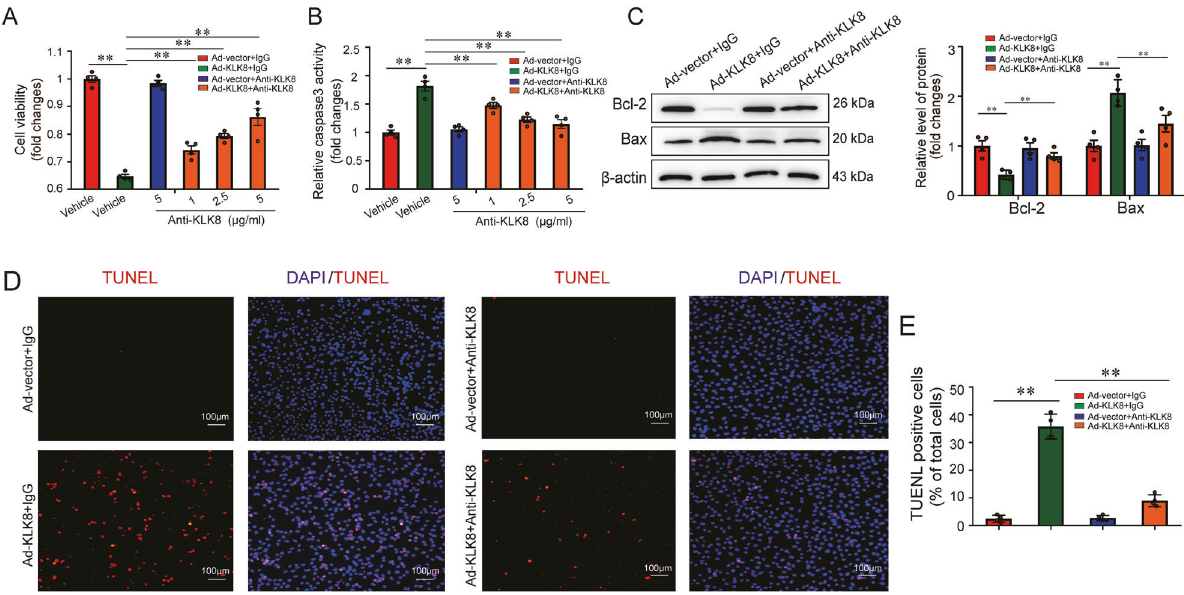
Fig. 5 Anti-KLK8 neutralizing antibody rescues KLK8-overexpressed neuron cells from apoptosis. HT22 murine hippocampal neuronal cells were infected with KLK8 adenovirus (Ad-KLK8) at a multiplicity of infection (MOI) of 3 for 24 h with or without anti-KLK8 neutralizing antibody at the indicated doses. A , B CCK8 assay and measurement of caspase-3 activity showed that anti-KLK8 antibody blocked Ad-KLK8-induced cell injury and caspase-3 activation in a dose-dependent manner in HT22 cells, respectively. C Protein levels of Bcl-2 and Bax were determined by western blot analysis. The representative protein bands (left) and the corresponding histograms (right) showed that anti-KLK8 antibody (2.5 μ g/ml) reversed Ad-KLK8-induced changes in protein levels of Bcl-2 and Bax. D Showed representative TUNEL-stained (red) cells. Nuclei were counterstained with DAPI (blue). Scale bar = 100 μ m. E The TUNEL-positive cell number (%) was shown as a ratio of the number of TUNEL-positive cells to the total cell number. D , E Showed that anti-KLK8 antibody (2.5 μ g/ml) reversed Ad-KLK8-induced HT22 cell apoptosis. Data were presented as means ± SD ( n = 4, one-way ANOVA, Bonferroni ’ s post hoc test). ** p < Fig. 3B, D) in HT22 and primary isolated neonatal neurons. In contrast, anti-apoptotic protein Bcl-2 expression (Fig. 4A, E and